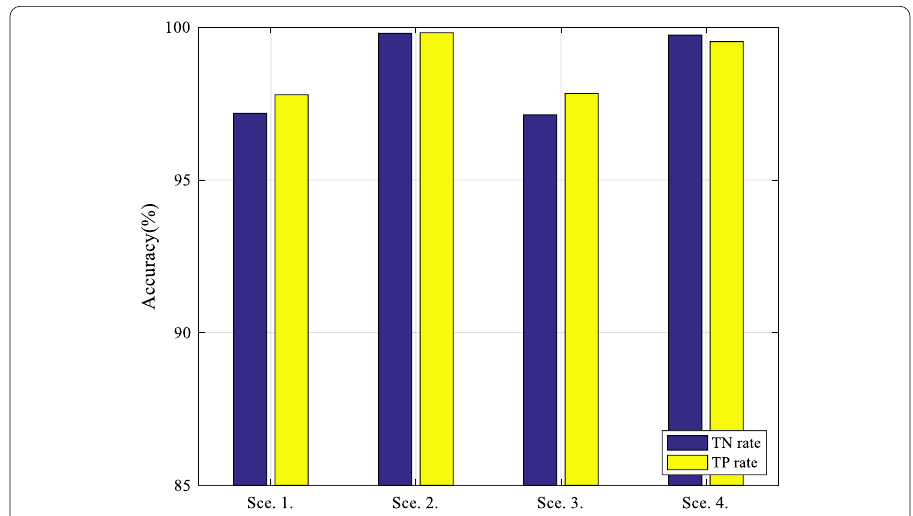
Fig. 9 TN rate and TP rate in four experimental scenarios with one participant